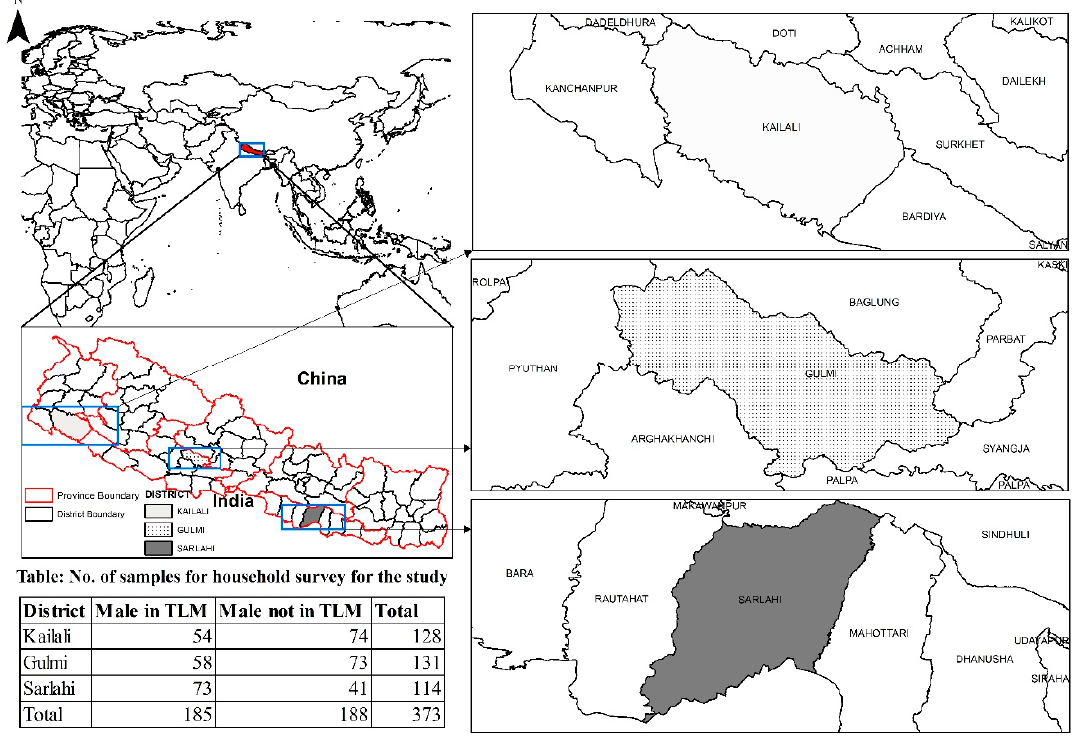
Figure 2. Map of the study area. The table in the figure represents the number of sample households considered in this study disaggregated by study area and migration status of the male.